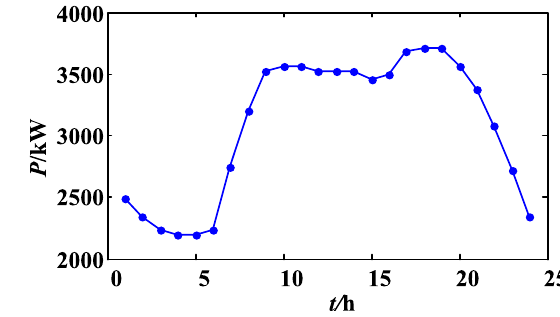
Fig. 6 Daily original building load